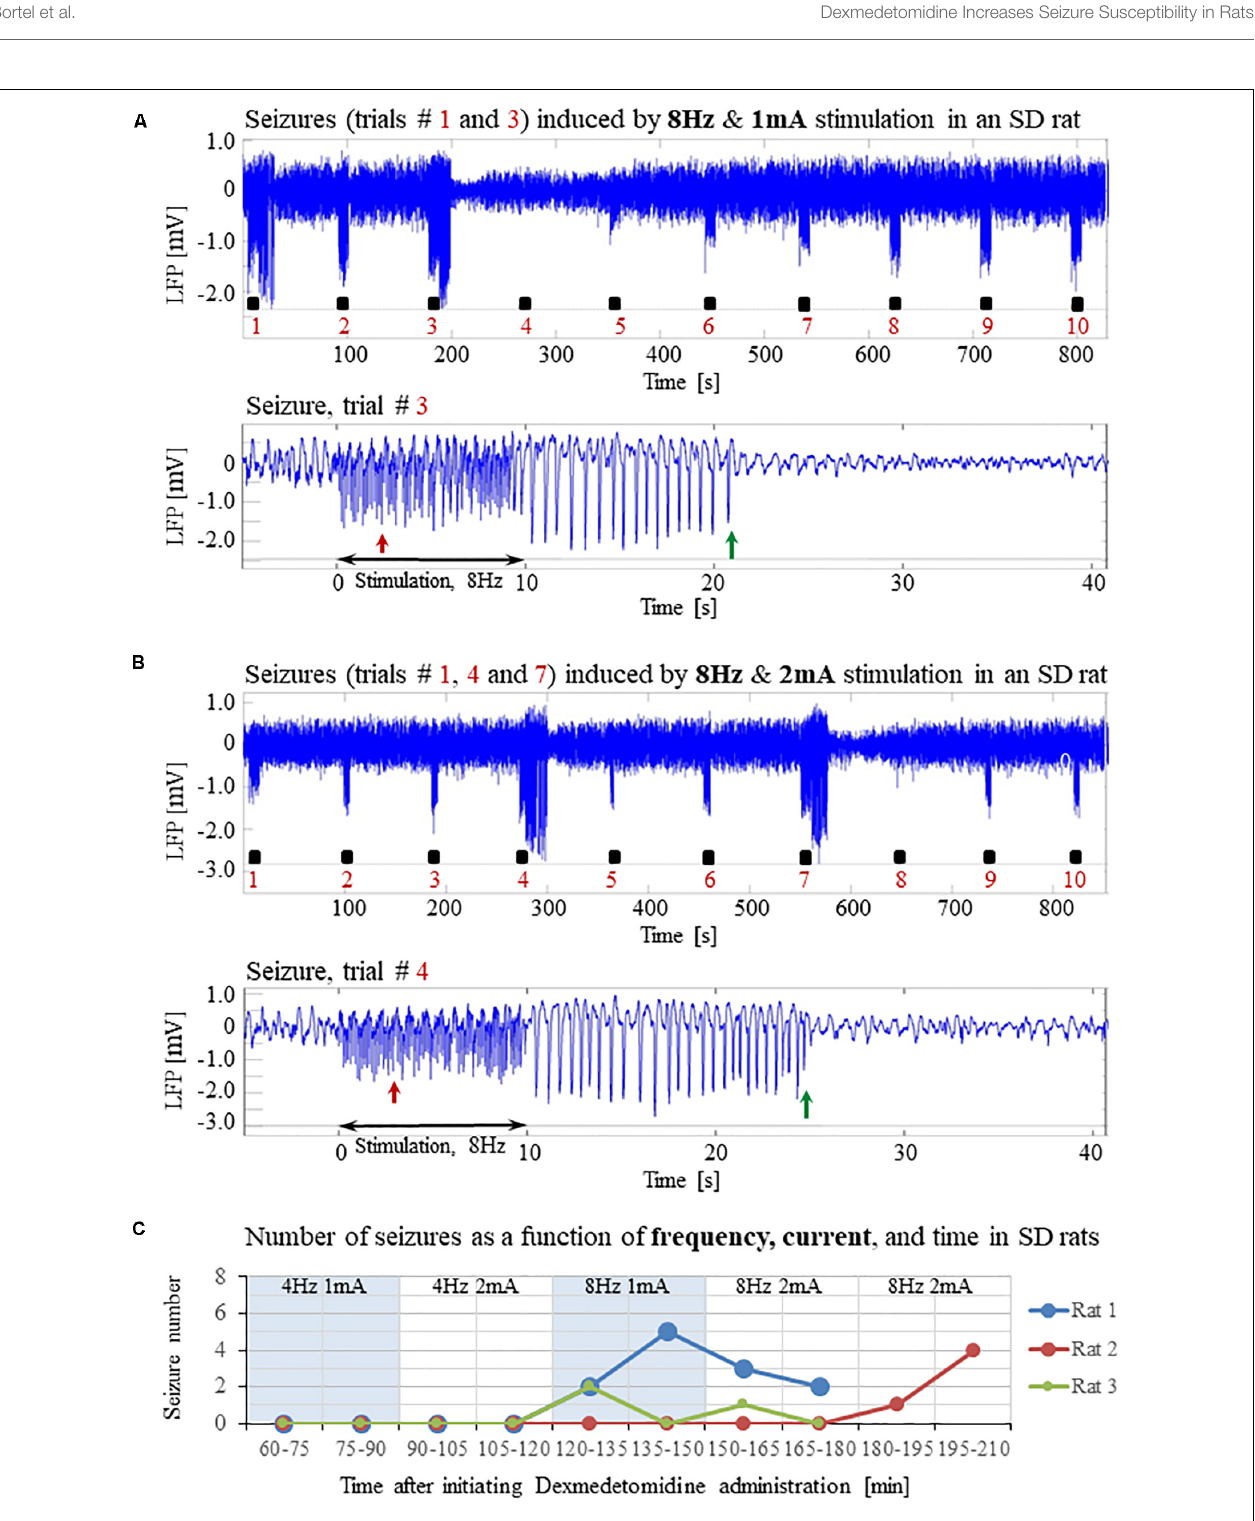
FIGURE 7 | Forepaw stimulation administered at 8Hz induces epileptic activity in SD rats under dexmedetomidine and buprenorphine. The data presented in this figure were obtained from the same 3 rats whose responses to forepaw stimulation with different parameters are presented in Figure 6 . (A) Top: LFP responses to 8 Hz & 1 mA forepaw stimulation. Note the seizures induced by the stimulus in the first and third trials. Bottom: A magnified view of the seizure recorded in the third trial. (B) Top: LFP responses to 8 Hz & 2 mA forepaw stimulation. Note the seizures induced by the stimulus in the first, fourth, and seventh trials. Bottom: A magnified view of the seizure recorded in the fourth trial. (C) The number of seizures recorded in each of the 3 rats whose responses to forepaw stimulation are presented in Figures 6 and 7 . The number of seizures is presented as a function of time after the initiation of the dexmedetomidine administration. The stimulation parameters used for each pair of consecutive blocks are presented at the upper part of the panel.